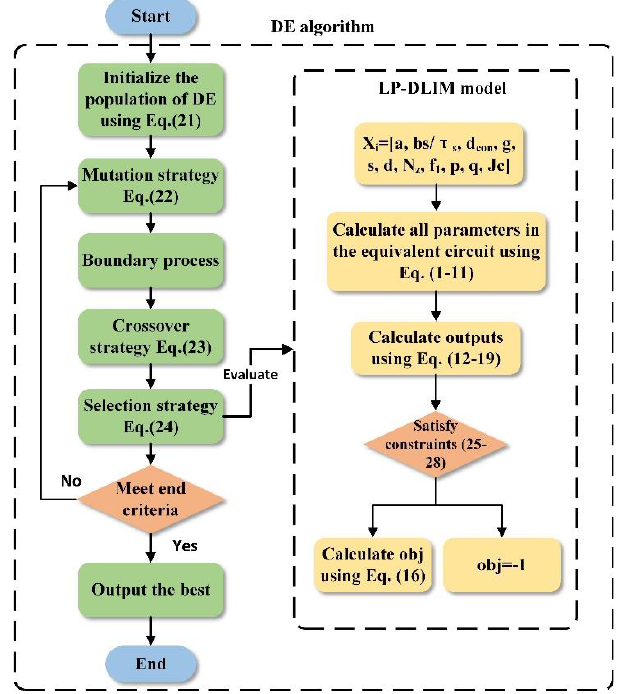
Figure 4. SP-DLIM design optimization process.